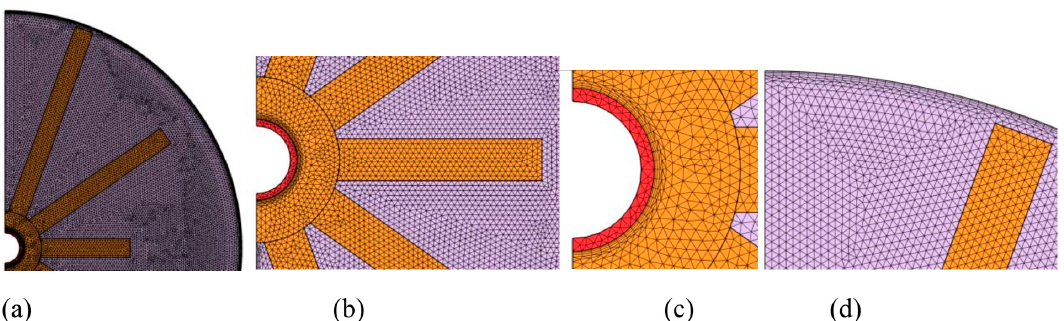
Figure 3. A view of utilized mesh for case Nmesh = 0.25. ( a ) An overall mesh view, ( b ) mesh details over the fins and PCM domain, ( c ) mesh details at the tube wall and metal foam layer, and ( d ) the mesh details at the fin edge and PCM domain outer wall.